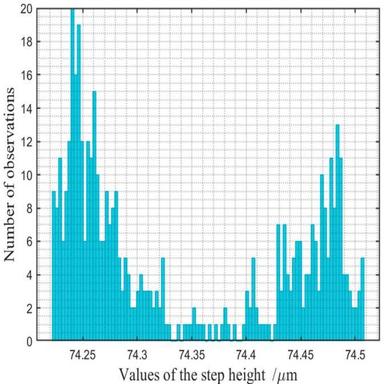
Distributions of the values of the step height calculated by the ISO based method.